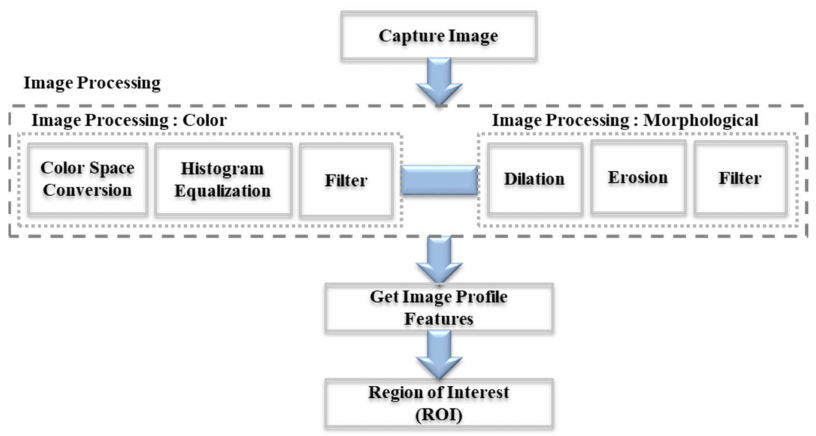
Figure 3. Flow chart of the image-processing